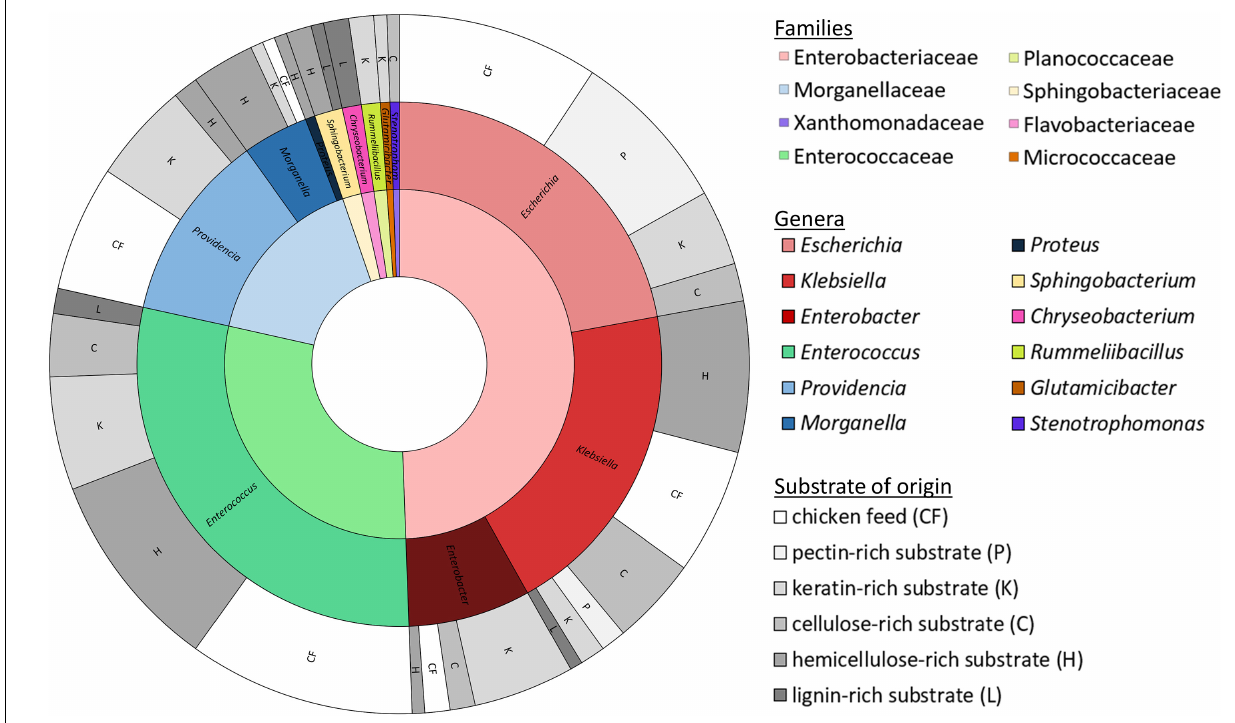
FIGURE 2 | Families (inner circle, cf. legend on the right side) and genera (middle circle, cf. legend on the right side) of the 172 identified isolates with the substrate of origin (outer circle; cf. legend on the right side).